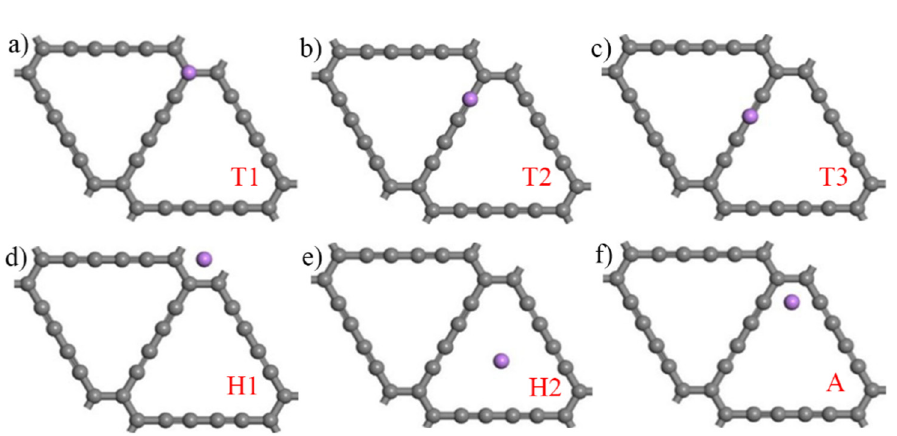
Figure 6. Six initial Li-GDY models (Purple ball is Li atom, ( a – f ) represent the Li atom adsorption points T1, T2, T3, H1, H2 and A, respectively). Table 3. Adsorption height and adsorption energy of six points for Li-GDY.